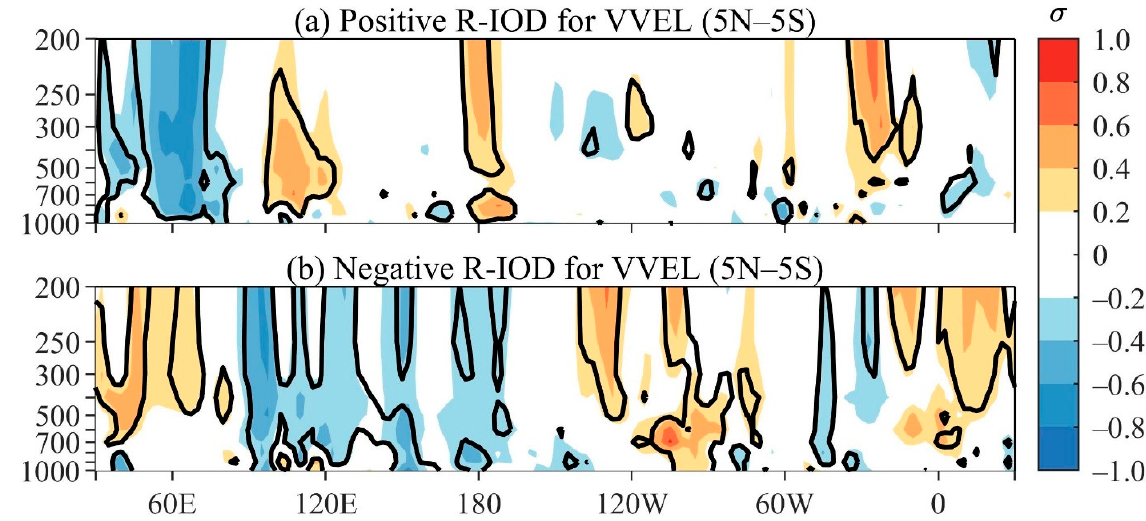
Figure 9. Longitude vertical cross-sections of the composites of the residual VVEL anomalies during austral spring for the: ( a ) positive R-IOD; and ( b ) negative R-IOD. In this Figure, residual means without the TPO effects. Graphical display is the same as that in Figure 4.